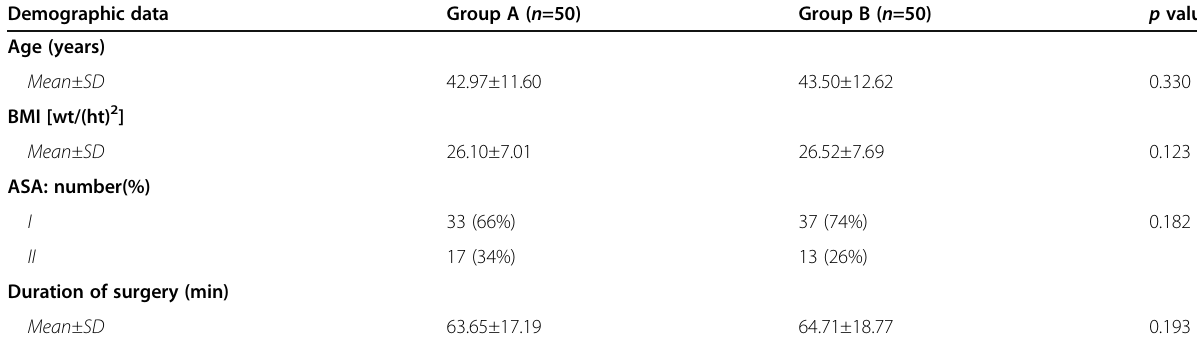
Table 1 Difference between group A and group B as regard demographic data Demographic